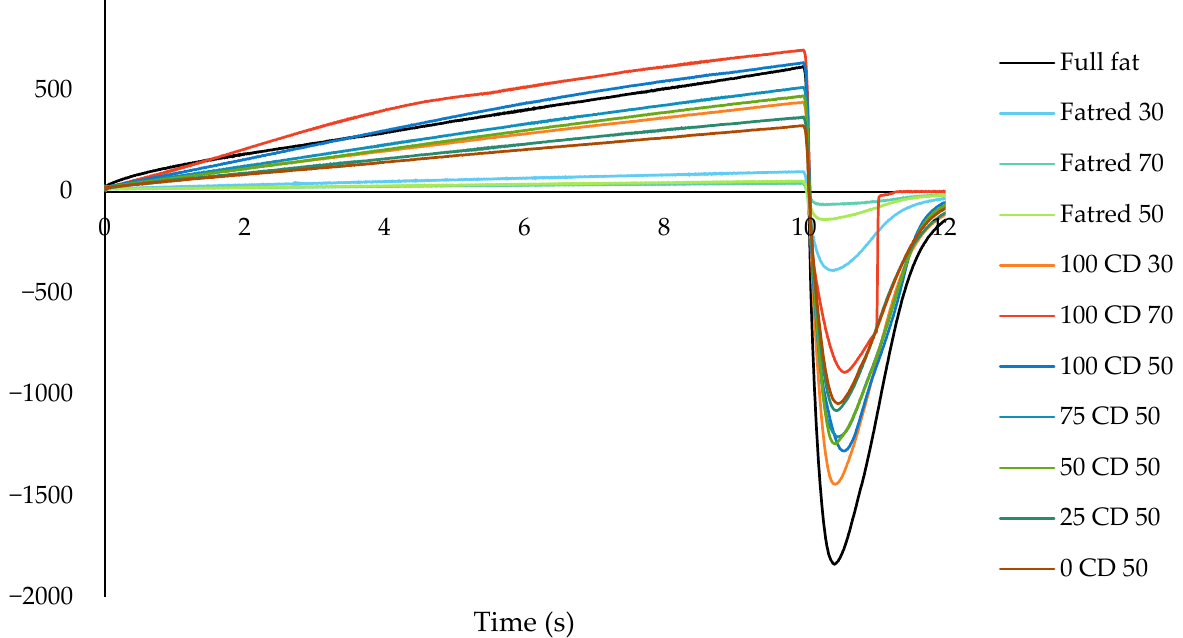
Figure A3. Force–time diagram of single measurements of all PCS formulations as example curves for the texture analysis.